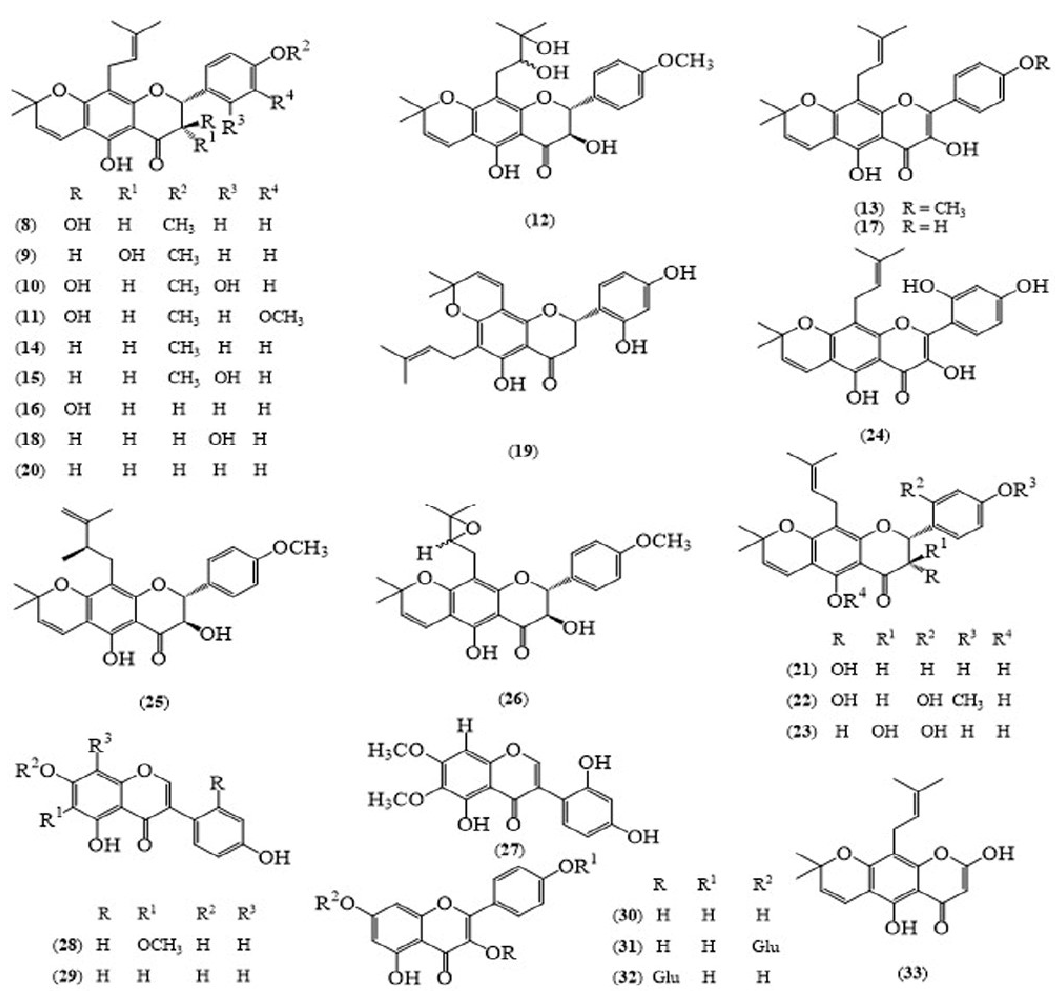
Figure 3. Structures of selected compounds isolated from Eriosema chinense. From the hexane, dichloromethane and methanol extract of the roots of E. chinense , seven flavonoids, trans - p -coumaric acid ester together with another twelve compounds were identified as